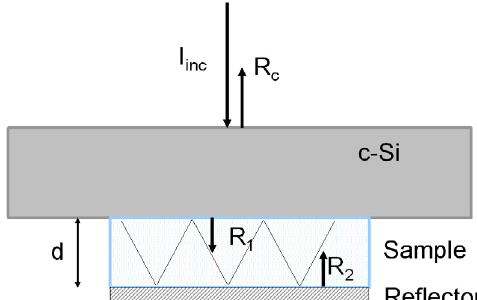
Fig. A.1. Schematic diagram of the incoming and outgoing incident excitation and converted emission in the complete sys- tem (solar cell + upconverter + reflector) (For details see